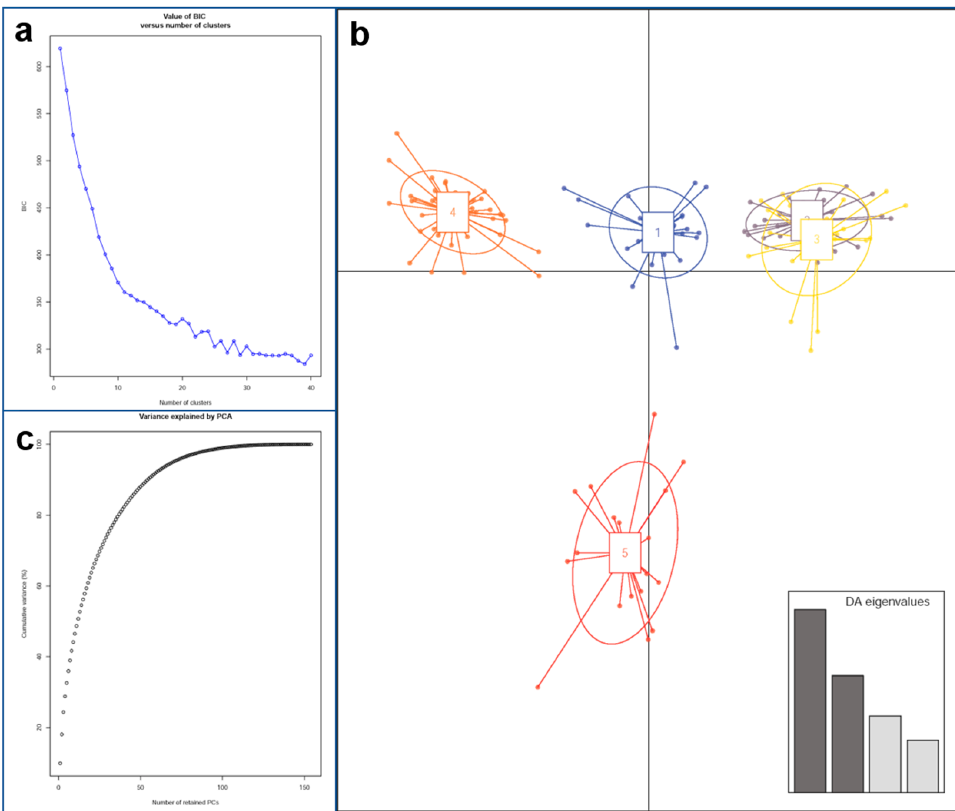
Figure 3. Summary of discriminant analysis of principal components (DAPC) for 155 soybean lines. ( a and c ), Optimal k number of genetic groups/clusters ( a ) and the percentage of cumulative variance for the retained principal component analysis (PCA) eigenvectors ( c ) based on the Bayesian information criterion. ( b ) Ordination plot of DAPC for the five groups and eigenvalues are given in bottom-right inset. Note: Genetic group/clusters are depicted by different colors and inertia ellipses whereas dots represent genotypes.